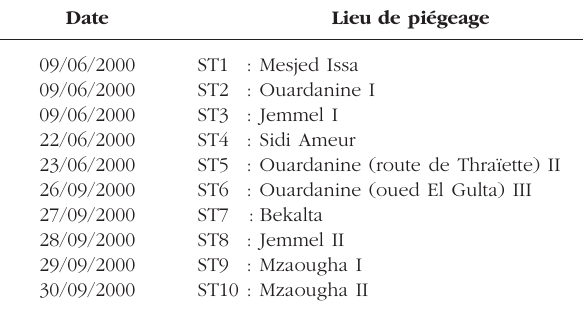
Tableau II. – Stations de captures.